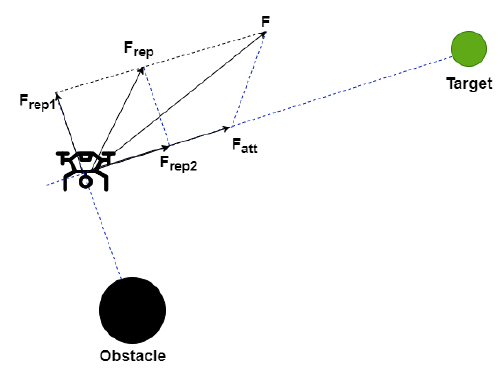
Figure 4. The improved resultant for model applied on the